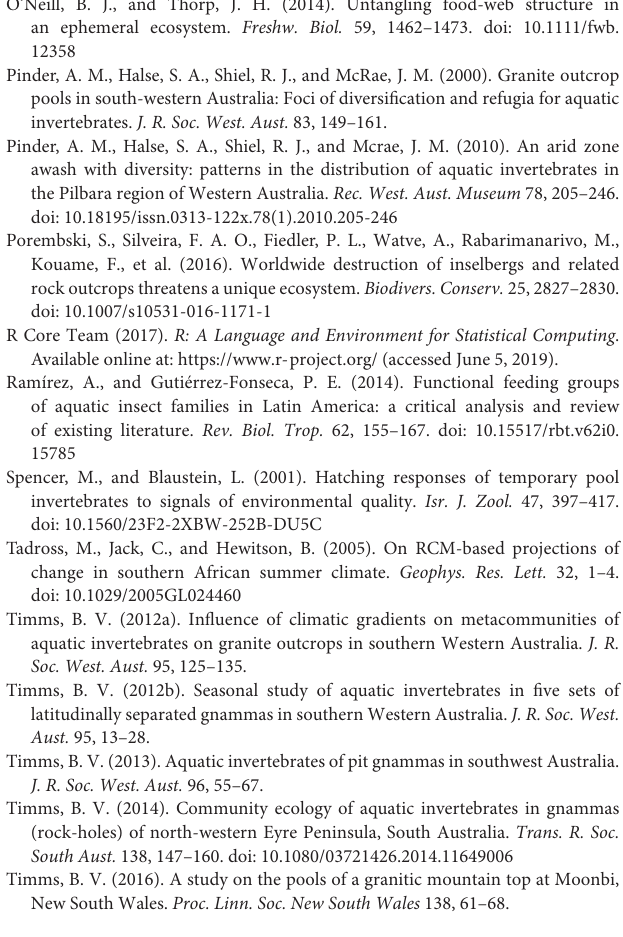
Tablelands, with special reference to the clam shrimp Paralimnadia urukhai (WebbandBell)( Crustacea:Branchiopoda:Spinicaudata ). Proc.R.Soc.Queensl